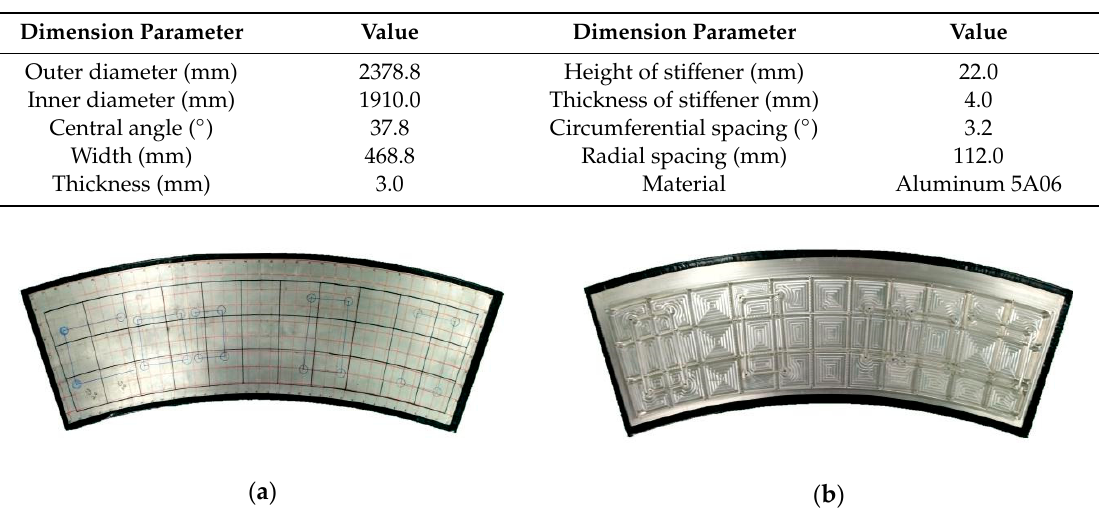
Figure 10. The fan-ring shaped high-sti ff ened panel actual structure diagram: ( a ) flat side; ( b ) sti ff ened side.